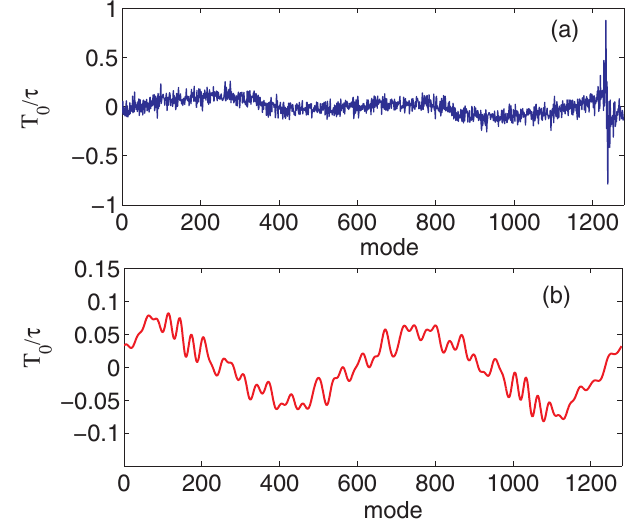
FIG. 14. (Color) Growth rate of coupled-bunch instability in bending magnet. Plots (a) and (b) depict the mode spectra of the horizontal and vertical coupled-bunch instabilities.